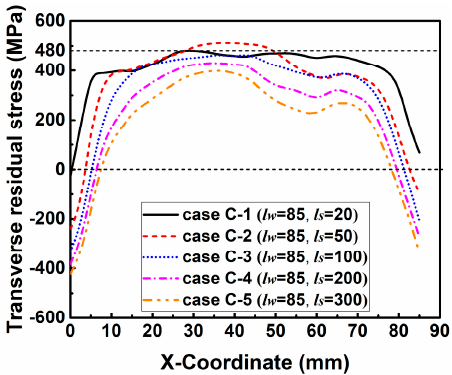
Figure 18. Transverse residual stress distribution along line 3 in cases of group C.